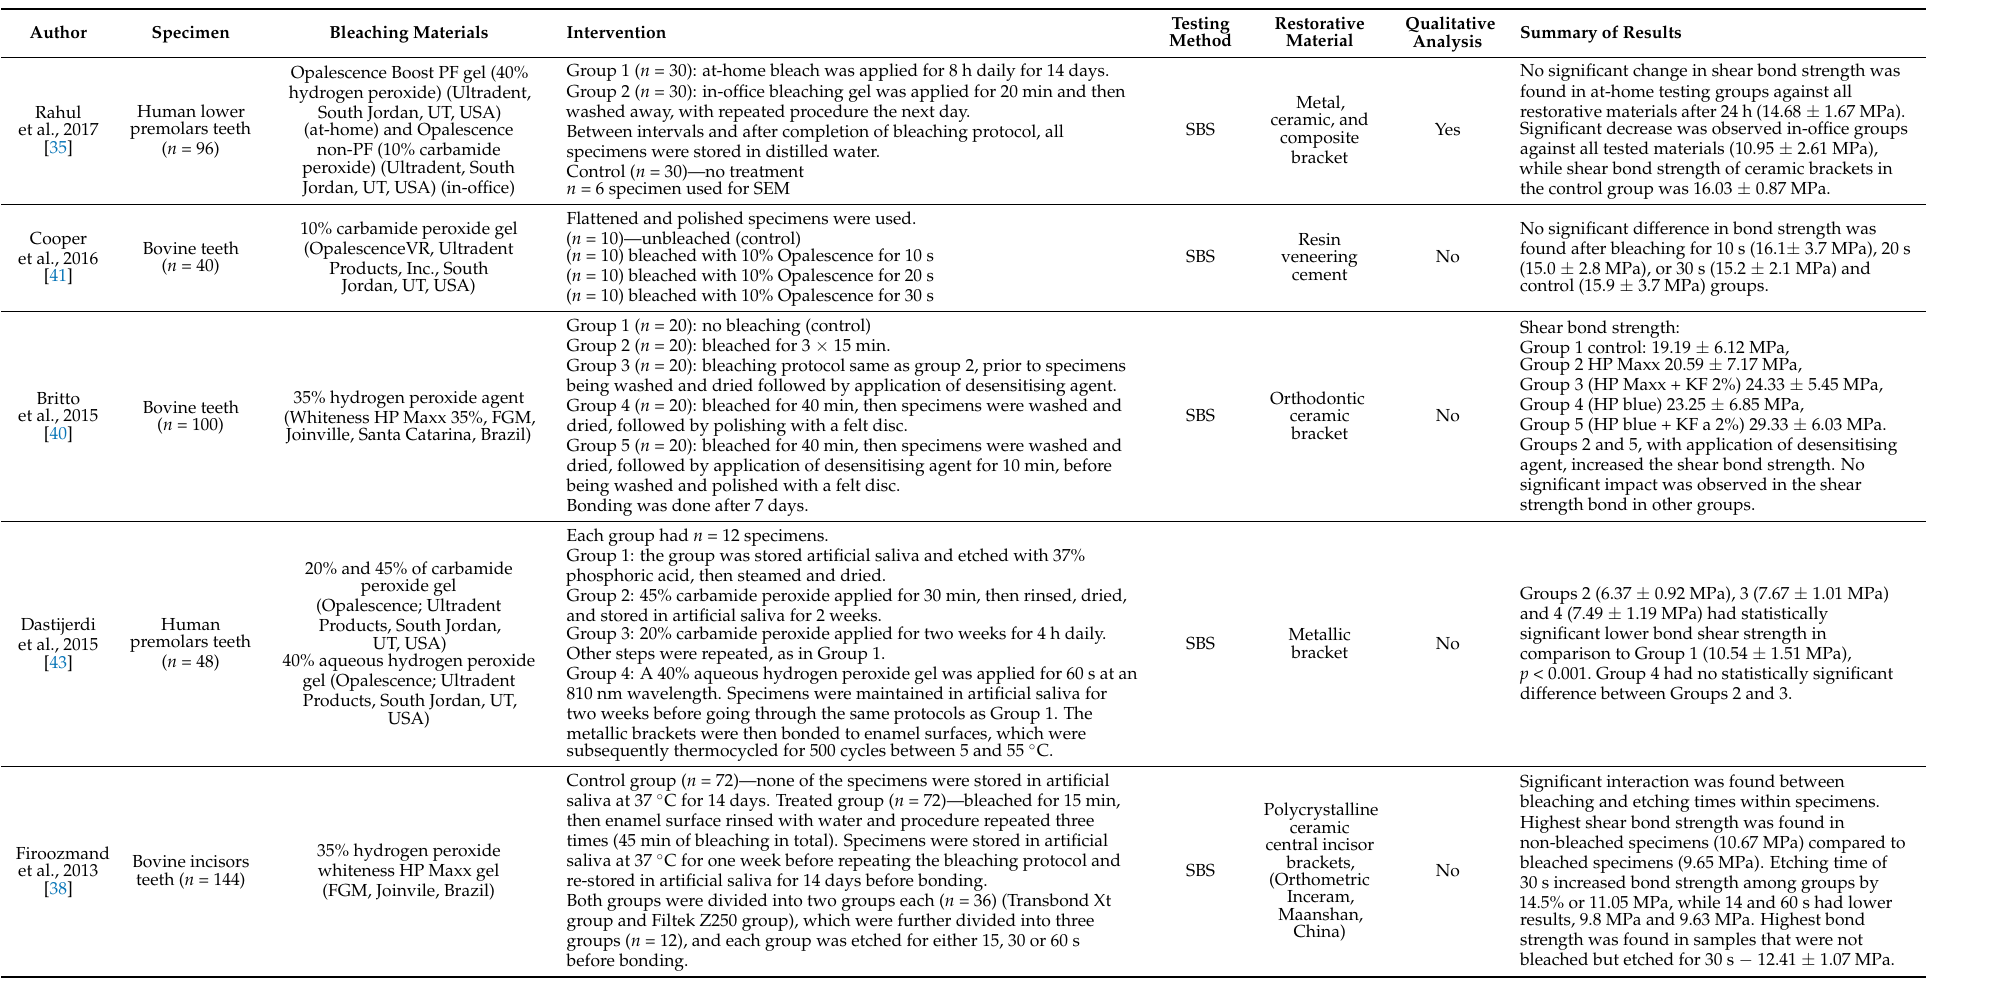
Table 3. Main findings of studies on bond strength of ceramic/metal to enamel after bleaching